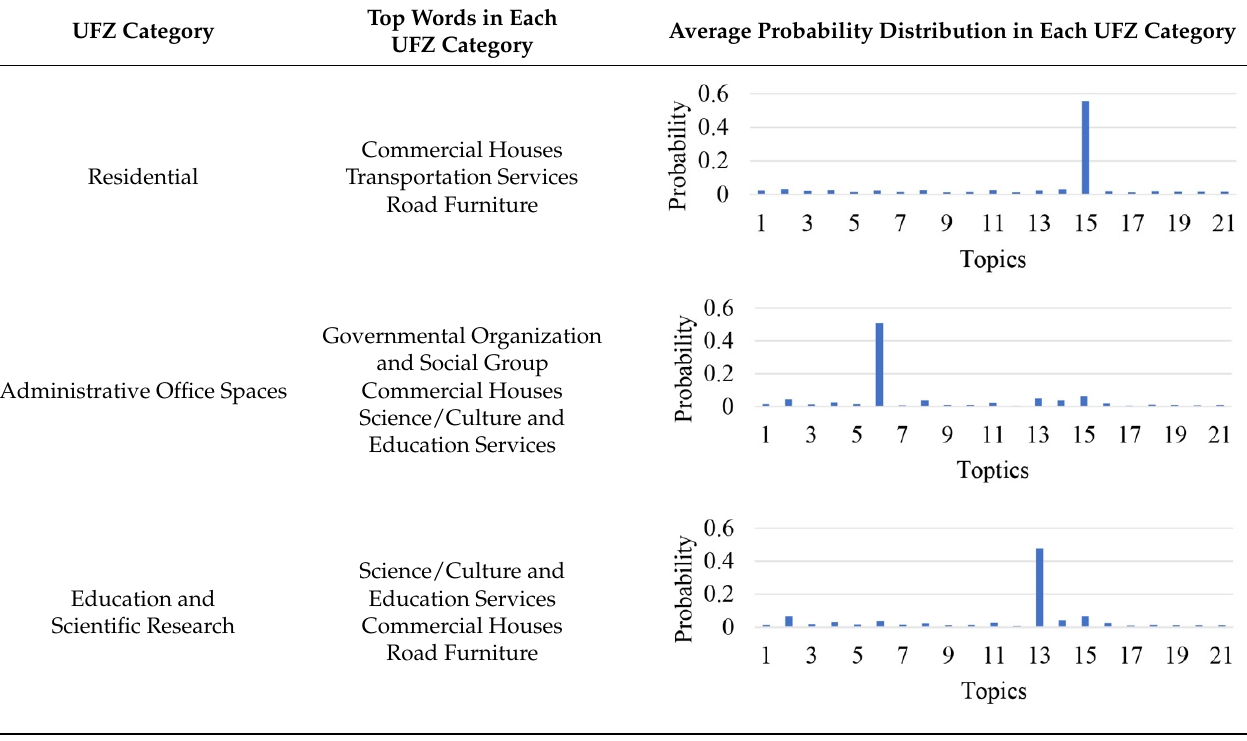
Table 3. Topics and top-three word distributions in the different UFZ categories.